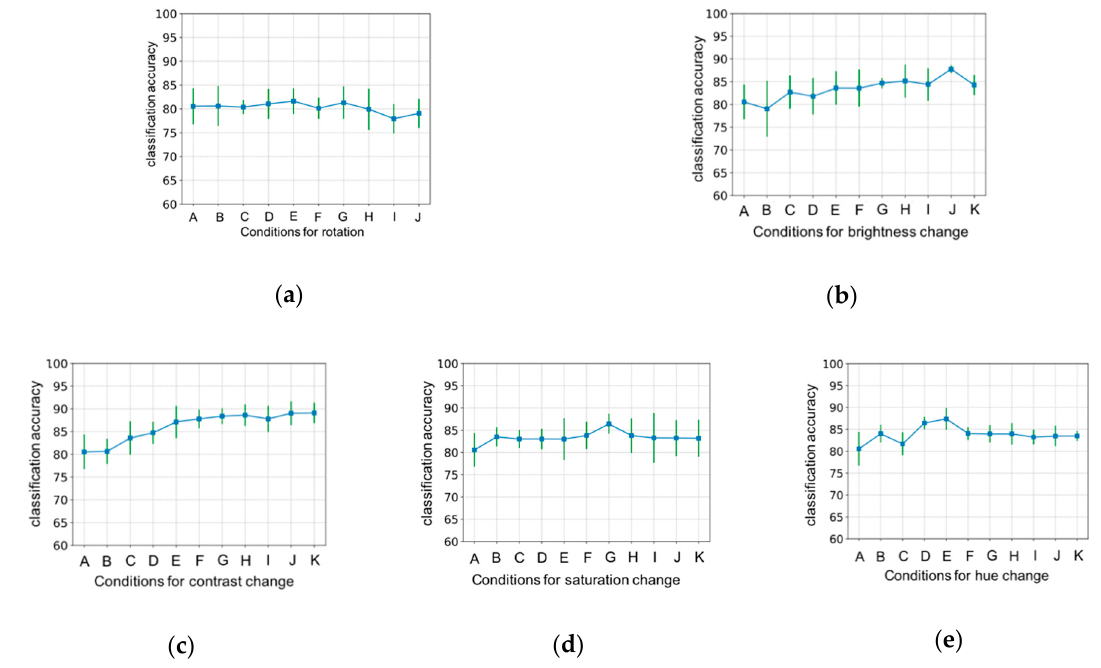
Figure 9. Classification accuracy due to variations in the data argumentation steps: ( a ) rotation, ( b ) brightness change, ( c ) contrast change, ( d ) saturation change, and ( e ) hue change.